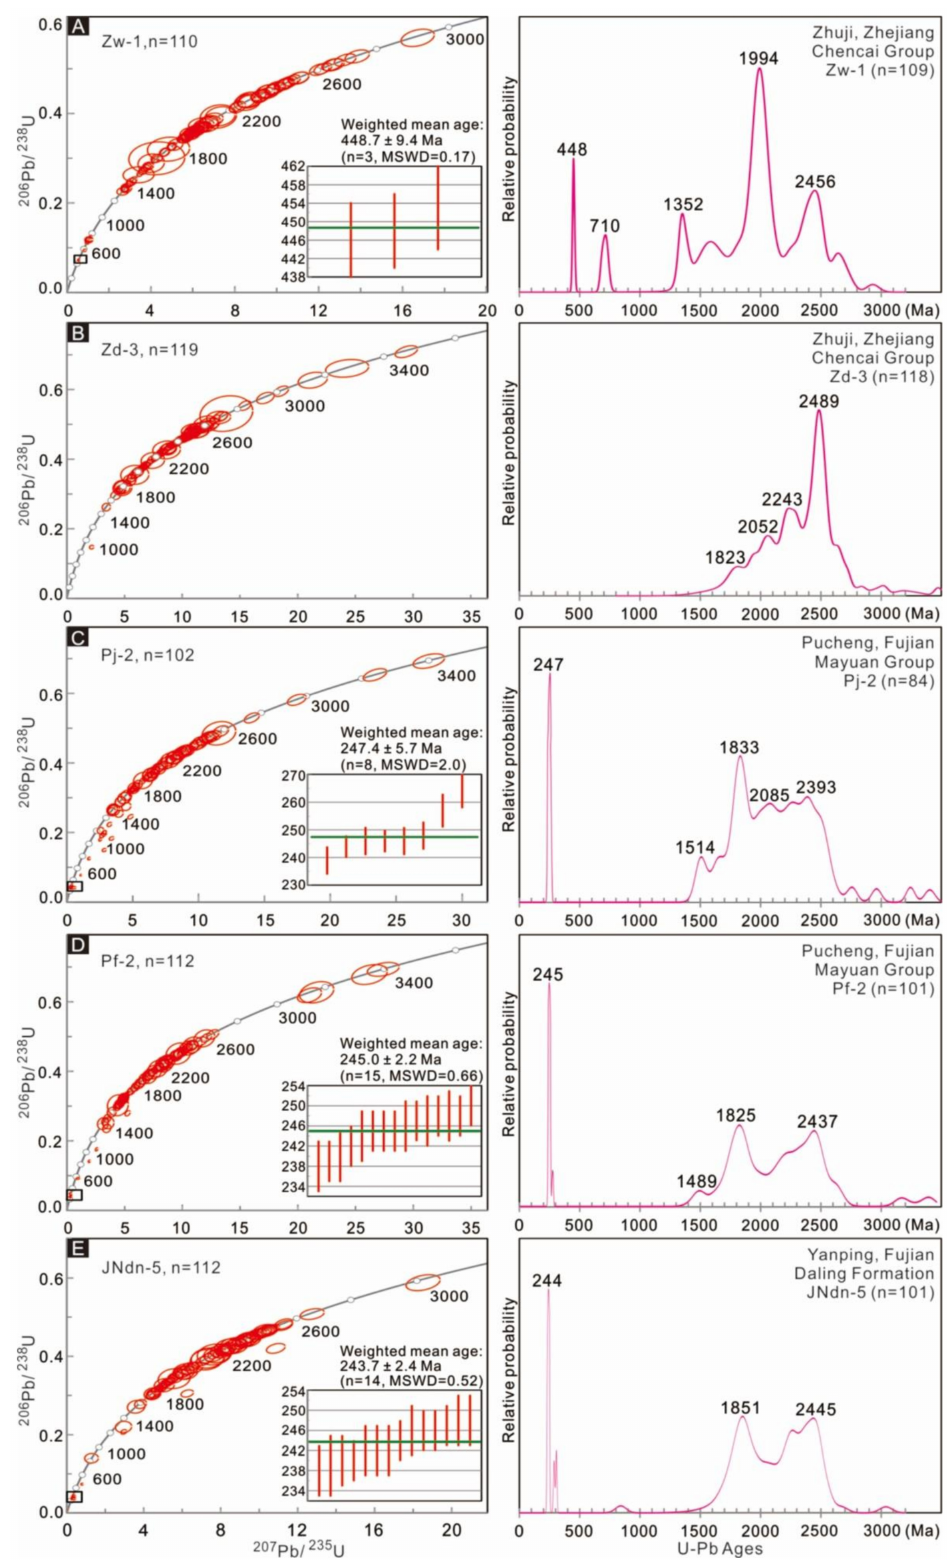
Figure 4. Concordia diagrams and age distributions for detrital zircon samples from the northeastern Cathaysia block (( A ) Zw-1; ( B ) Zd-3; ( C ) Pj-2; ( D ) Pf-2; ( E ) JNdn-5). Sample Pf-2 was also taken from the Mayuan Group, from which a total of 112 analyses were conducted on 82 zircon grains (Table S1). Similar to those of sample